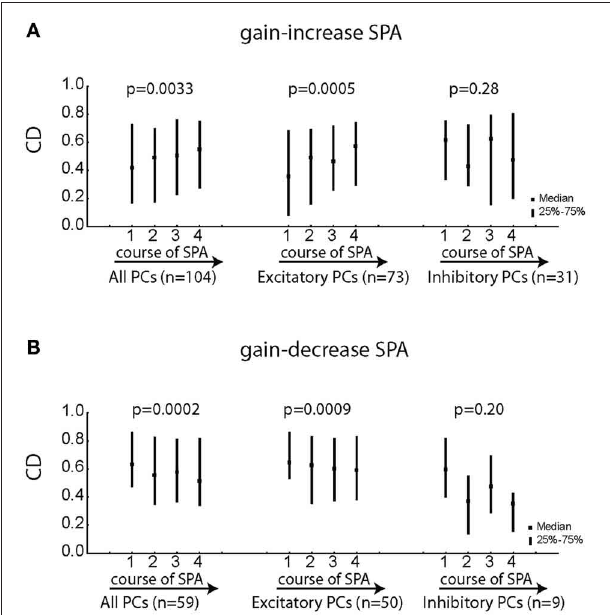
FIGURE 8 | Changes in the coefficient of determination ( CD = r ²) for the equation [spk( t − (cid:2)) = f × vel ( t ) + h ] with (cid:2) = 15ms for various subgroups of PC SS during gain-increase SPA (A) and gain-decrease SPA (B). The left column shows the median/quartile values of CDs for the four bins capturing the course of SPA for the entire population of PC SS. The middle column represents the excitatory PC SS and the right column depicts the population of inhibitory PC SS. Significant changes of the CD during the course of SPA were assessed with Friedman ANOVAs. Excitatory PC SS showed a highly significant increase in CD along the course of gain-increase SPA while inhibitory PC SS exhibited no change during gain-increase SPA. Similarly, excitatory PC SS showed a highly significant decrease in CD during the course of gain-decrease SPA with no changes observed for inhibitory PC